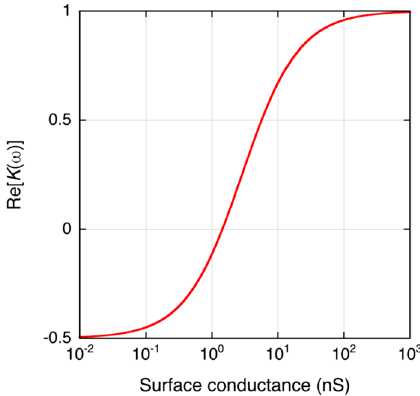
Figure 2. Theoretical calculation of the dependence of Re[ K ( ω )] of a dielectric microbead ( r = 2.8 μ m) on its surface conductance. The parameters for the calculation are: ε p = 2.4 × ε 0 F/m, ε m = 78 × ε 0 F/m, ε 0 = 8.854 × 10 − 12 F/m, σ m = 2 × 10 − 3 S/m, and ω = 2 π × 10 5 rad/s. The surface conductance is typically 1 nS for latex particles [13].